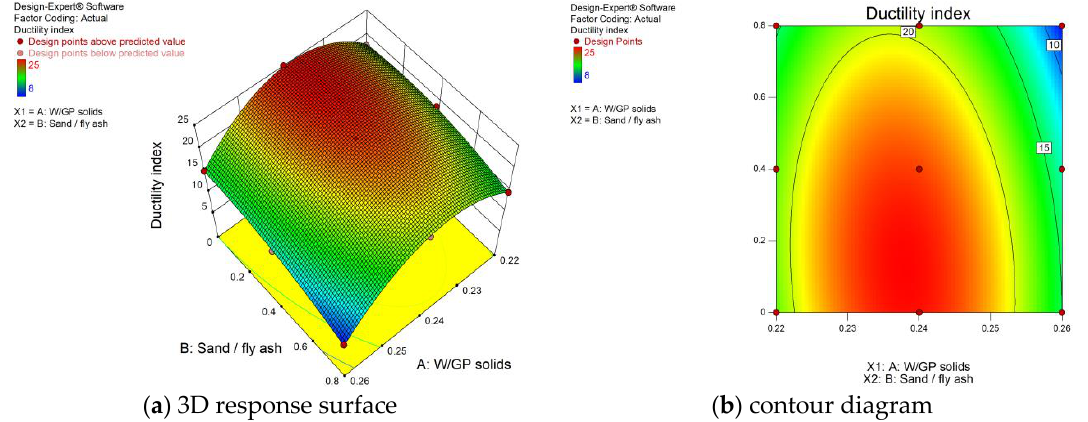
Figure 10. Ductility index versus W/GP solids and sand/fly ash. ( a ) 3D response surface, ( b ) contour diagram.